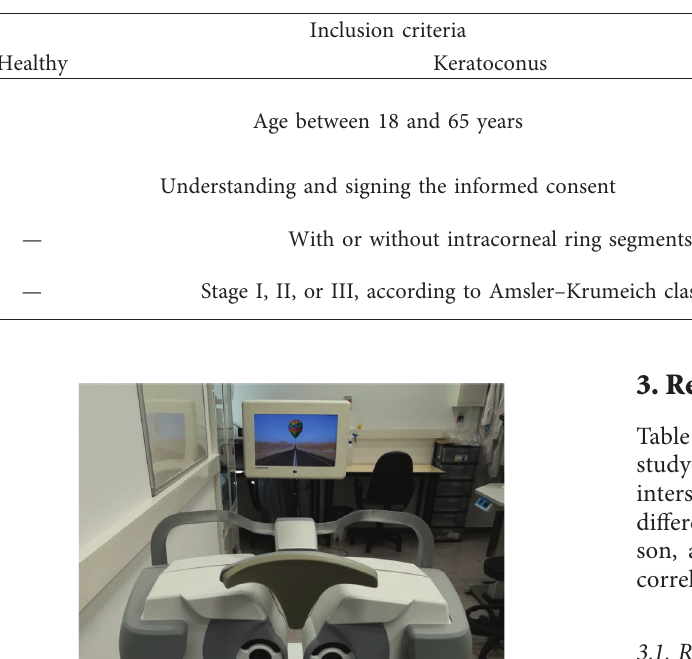
Table 2: Inclusion and exclusion criteria of the participants in the study.